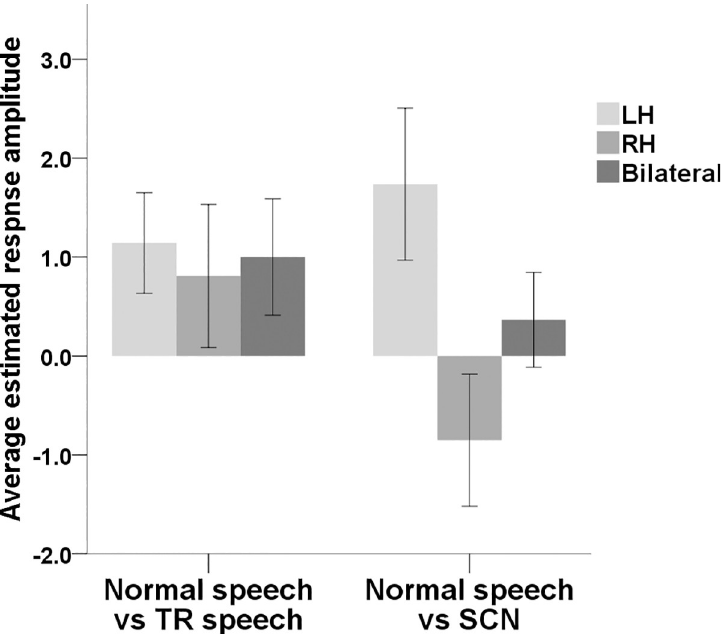
Fig 6. Mean ERAs (N = 20) for each auditory condition contrast derived from posterior temporal regions. Mean ERAs are shown for channels 32 and 13, targeting posterior temporal regions in the LH and RH respectively. Bilateral ERAs (average across these two channels) are also shown. Error bars show ± 1 standard error of the mean.